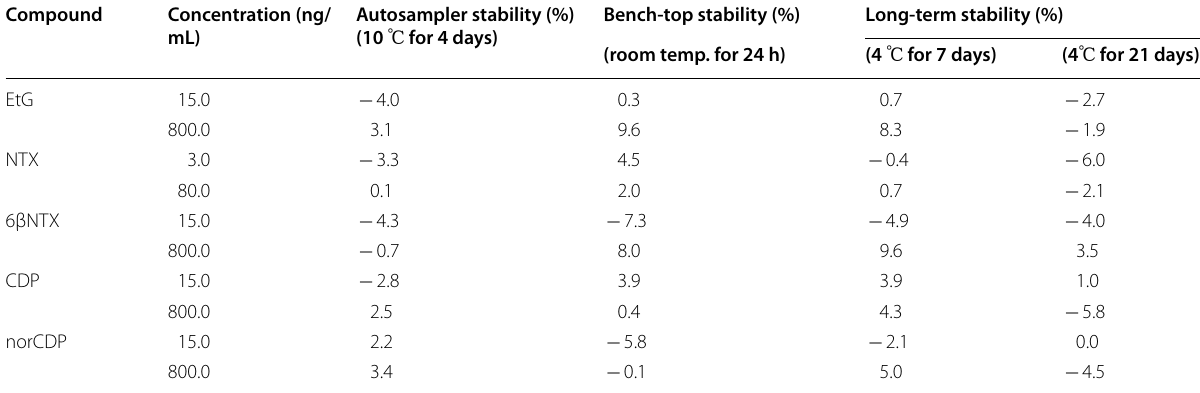
Table 5 Stability of the analytes ( n